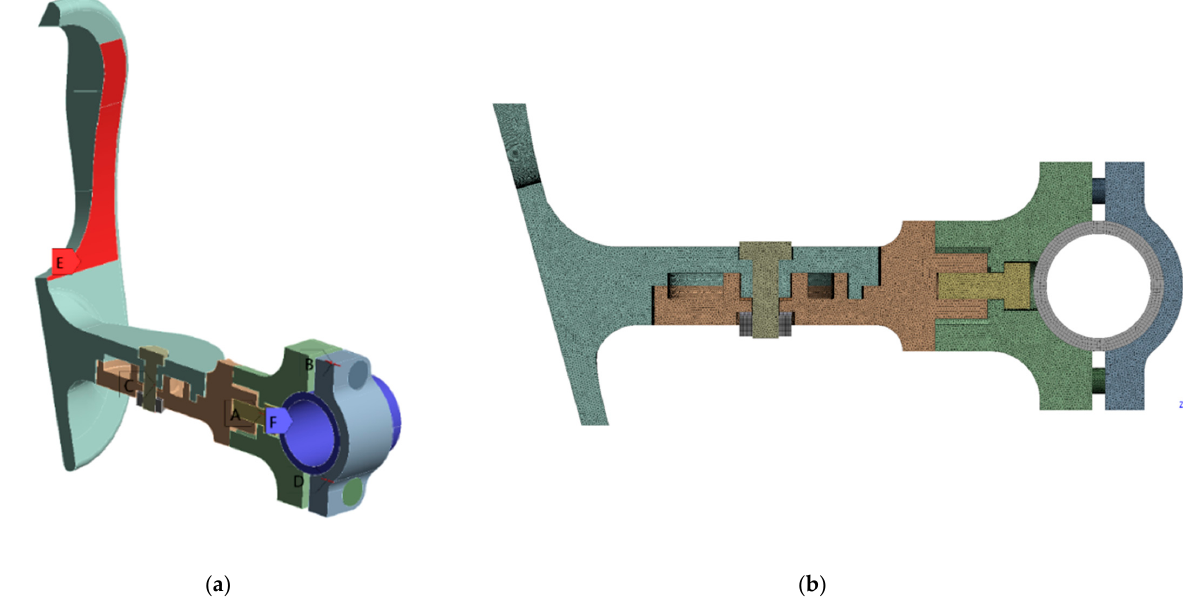
Figure 11. Representation of the finite element model for the dynamic system: ( a ) E—surface for applied force; F—boundary surface; A—bolt connection between the components for; B—bolt connection for clamping the system to the handle; C—rotational pin; ( b ) visualization of the mesh.